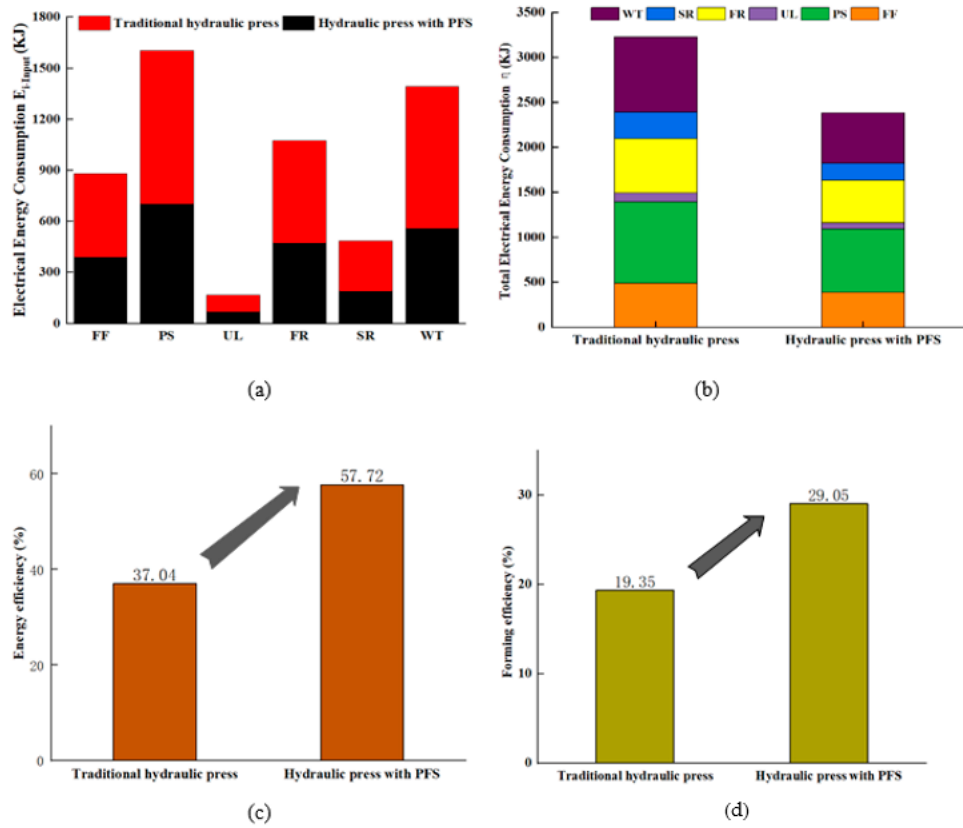
Figure 10. ( a ) Energy consumption under different processing stages; ( b ) Total energy consumption; ( c ) Total energy efficiency; ( d ) Forming efficiency.